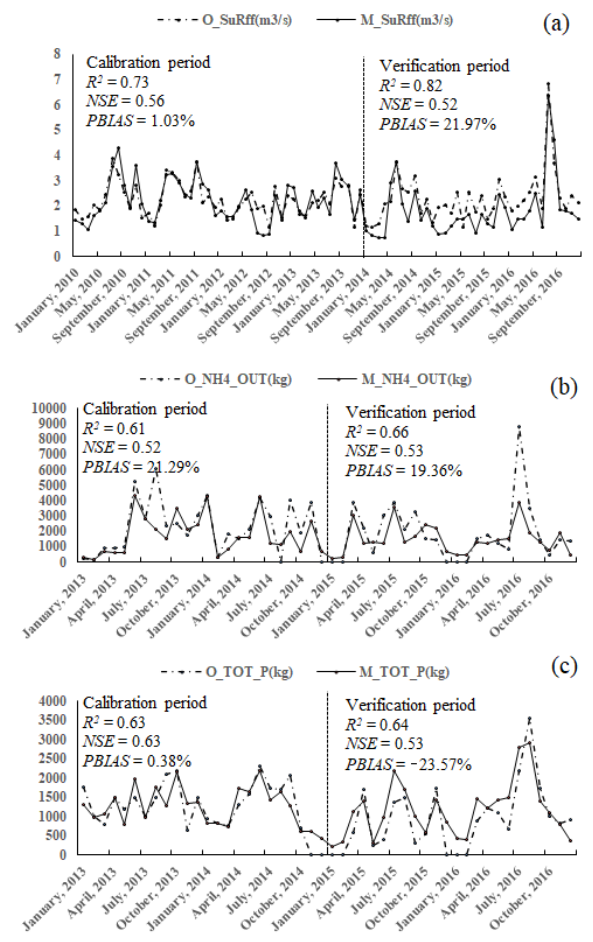
Figure 6. Simulation results of monthly runoff ( a ), ammonia ( b ), and total phosphorus ( c ). SuRff, NH4_OUT and NH4_OUT demotes monthly outputs of runoff, ammonia, and total phosphorus, and the letters O and M denote observed and simulated values, respectively. R 2 , NSE , and PBIAS denote goodness of fit, Nash efficiency factor, and percentage error, respectively.